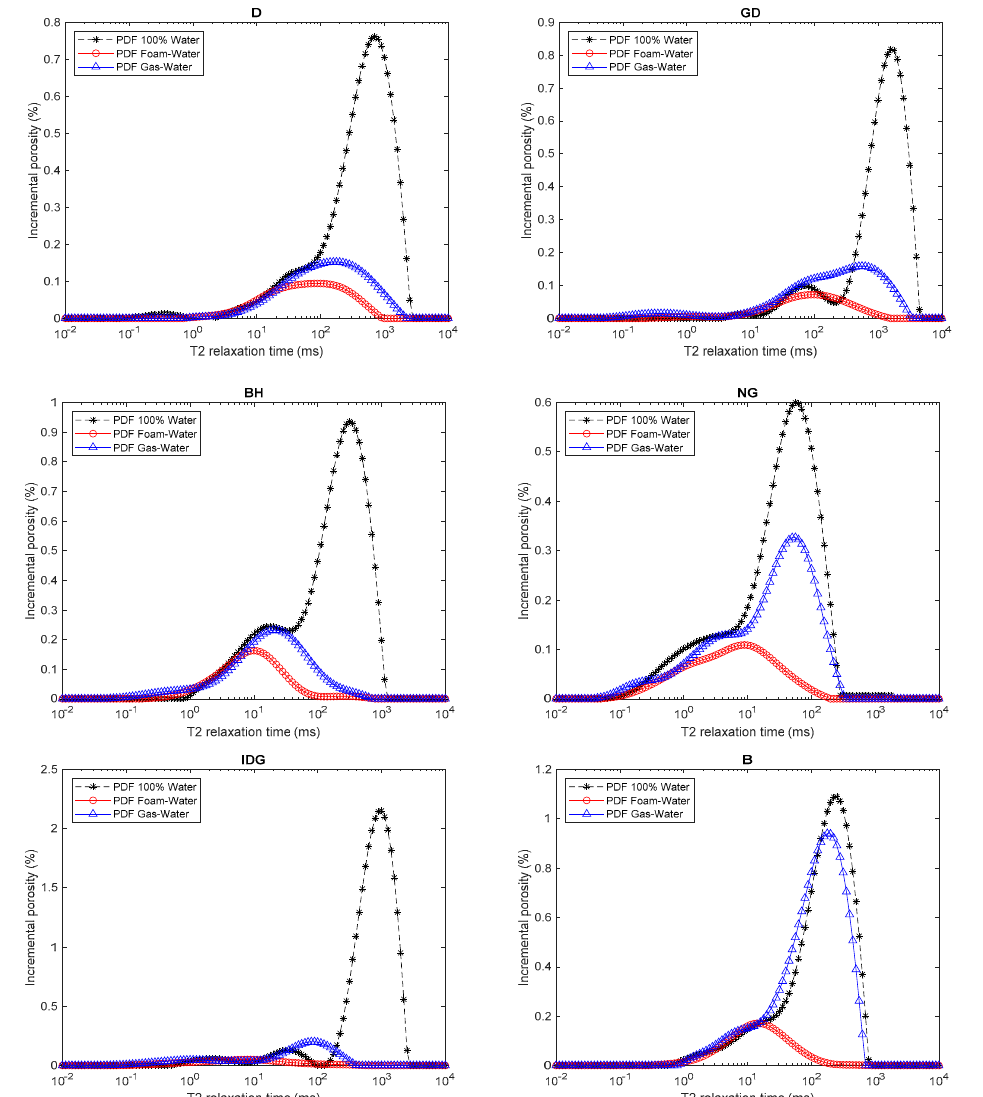
Figure 11. Comparison of the NMR T 2 profile after gas and foamed gas injection in different rock samples initially saturated with water.